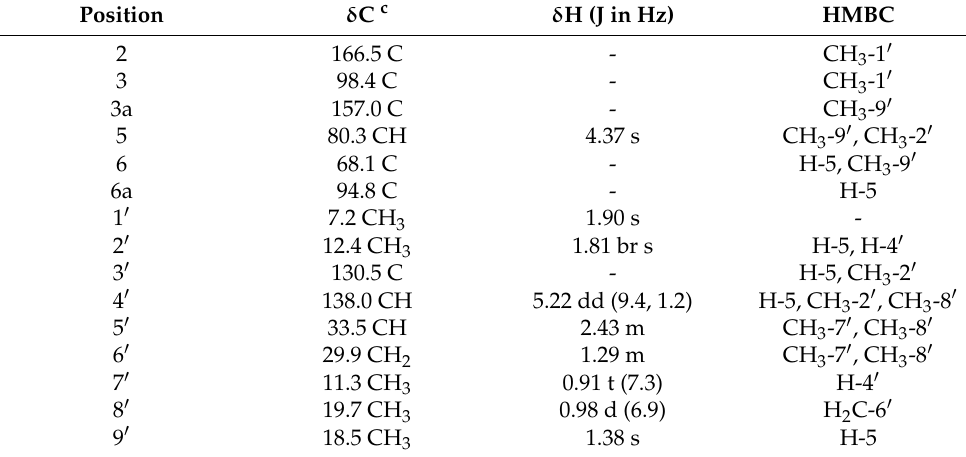
Table 1. 1 H and 13 C NMR data of araufuranone ( 1 ) recorded in CDCl 3 a,b